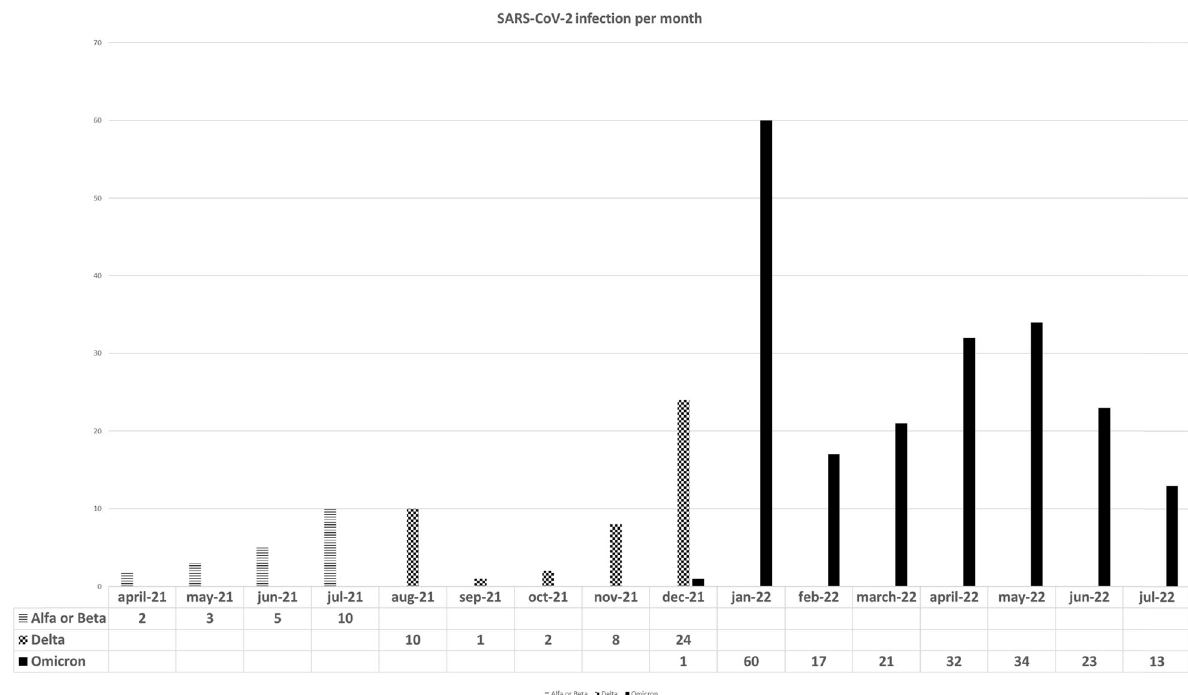
Fig. 1 Epidemiological distribution of reported SARS-CoV-2 breakthrough infections in the whole cohort according to the likelihood of SARS- CoV-2